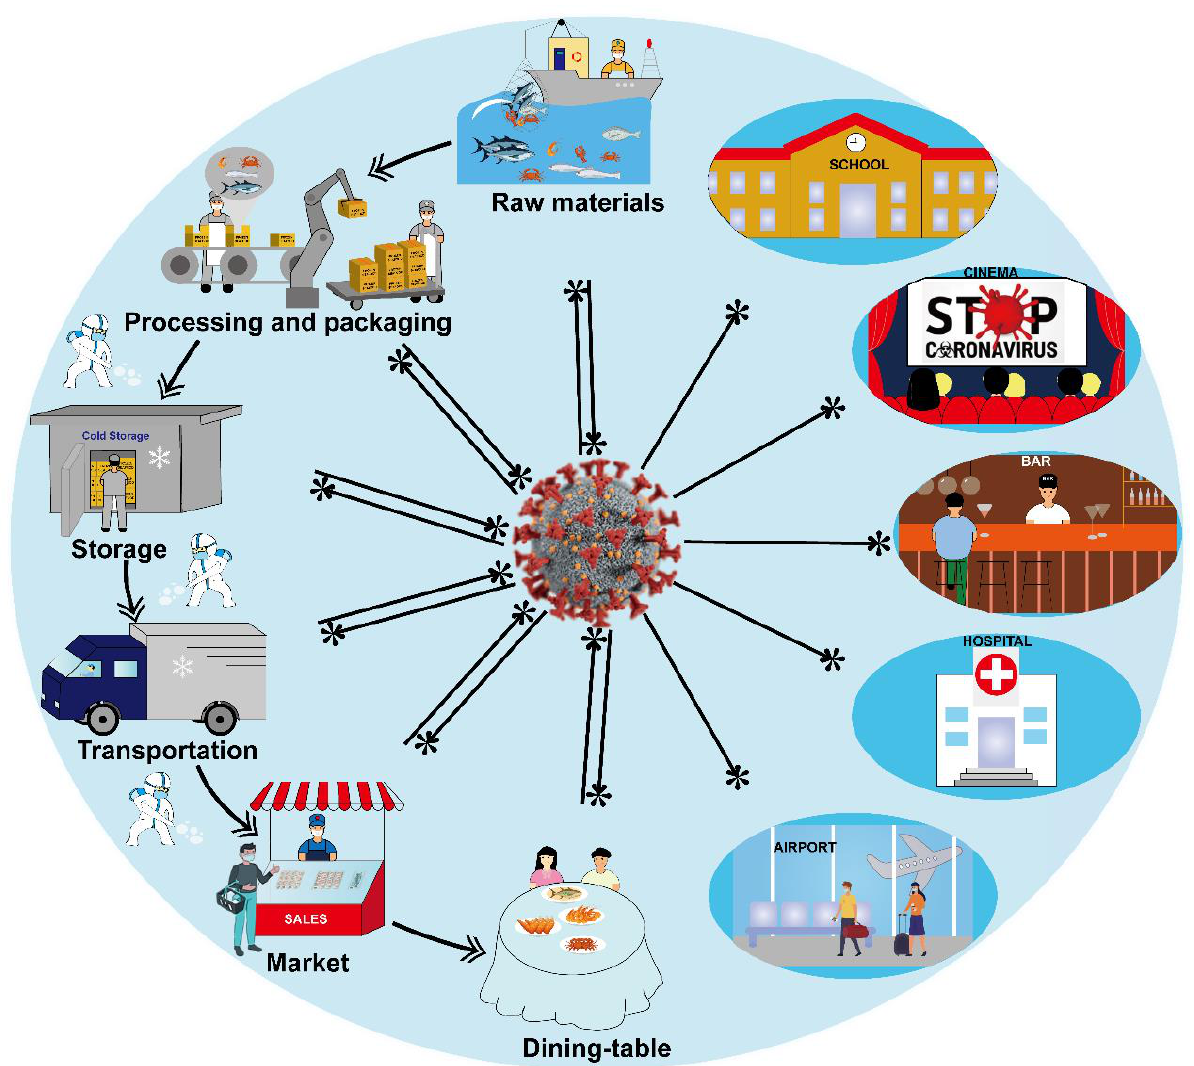
Figure 4. The potential transmission and infection of SARS-CoV-2 in cold-chain links, such as foods, personnel involved in the operation, the whole cold-chain links, waste and disinfection and sterilization procedures, etc.